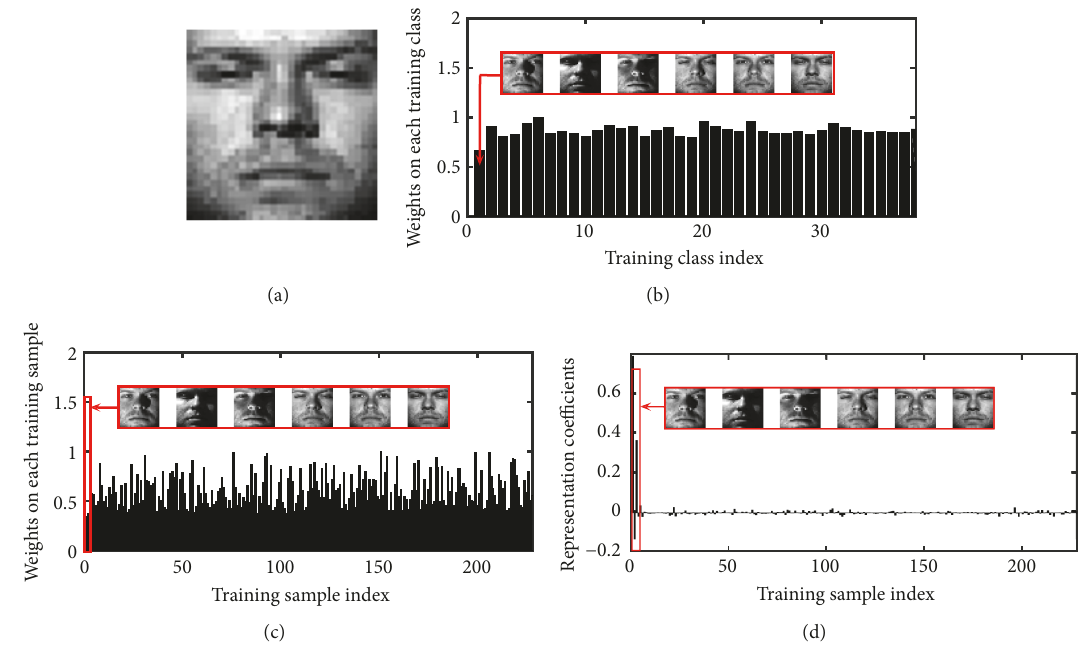
Figure 2: An example for proposed method on 228 training samples of 38 subjects from Extended Yale B database [51]. (a) A test sample from Class 1; (b) the weight on each training class; (c) the weight on each training sample; (d) the representation coefficients obtained by our